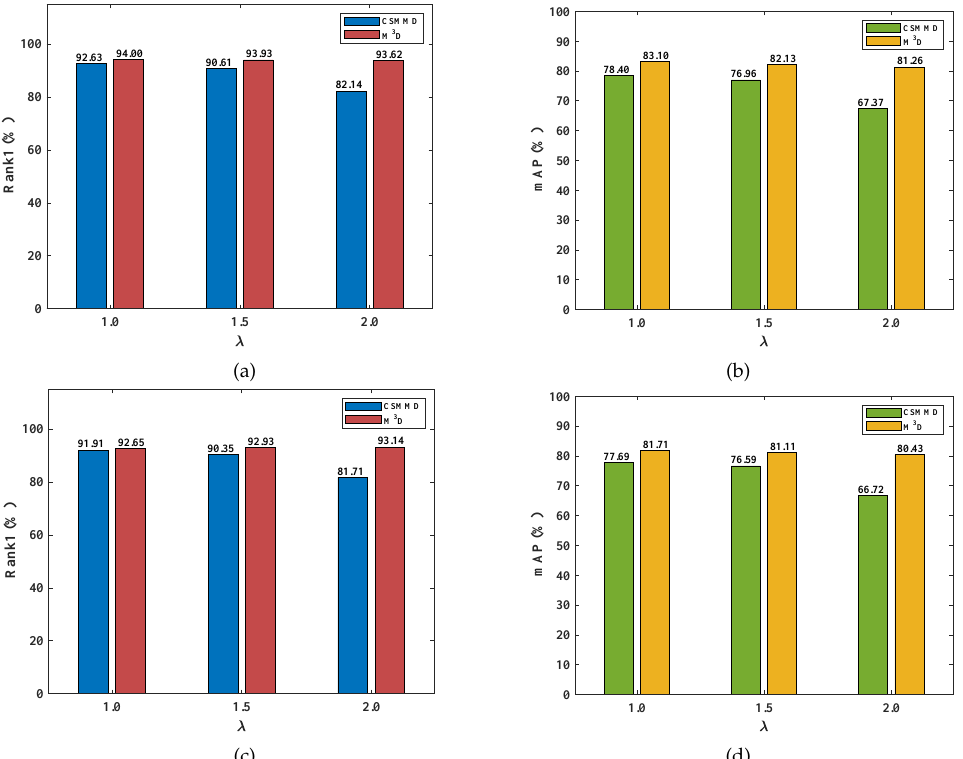
Figure 4. The comparison between our M 3 D and CSMMD [28] loss functions on the RegDB dataset. ( a ) V2I Rank1, ( b ) V2I mAP, ( c ) I2V Rank1, and ( d ) I2V mAP.